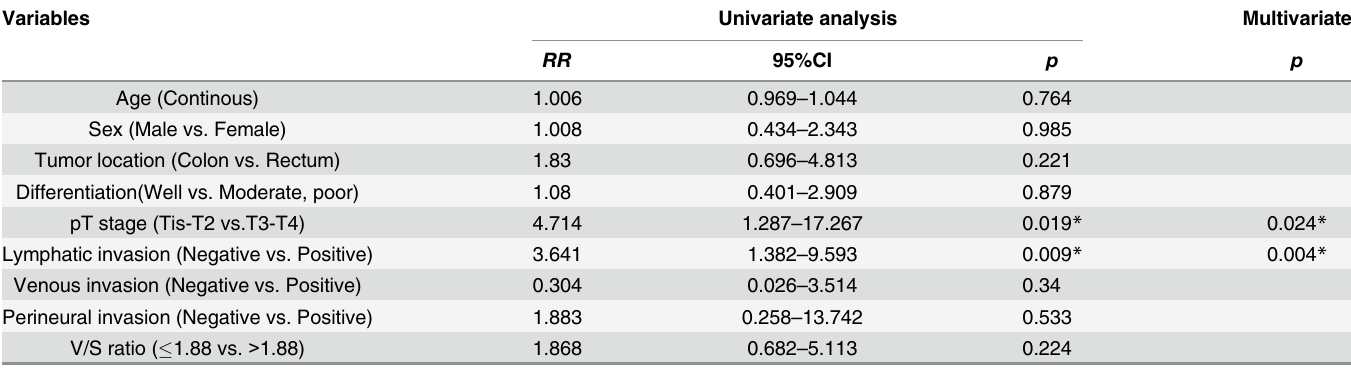
Table 3. Uni- and multivariate analyses for predicting regional lymph node metastasis without distant metastasis. Variables